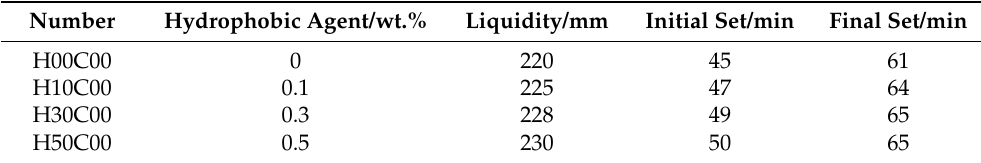
Table 3. Influence of the hydrophobic agent content on the fluidity and setting time of the phospho- gypsum slurry. Hydrophobic